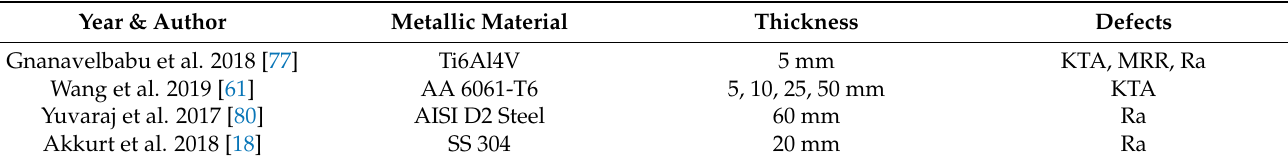
Table 4. Quality defects in AWJ cutting of metallic with different thickness [18,61,77,80].